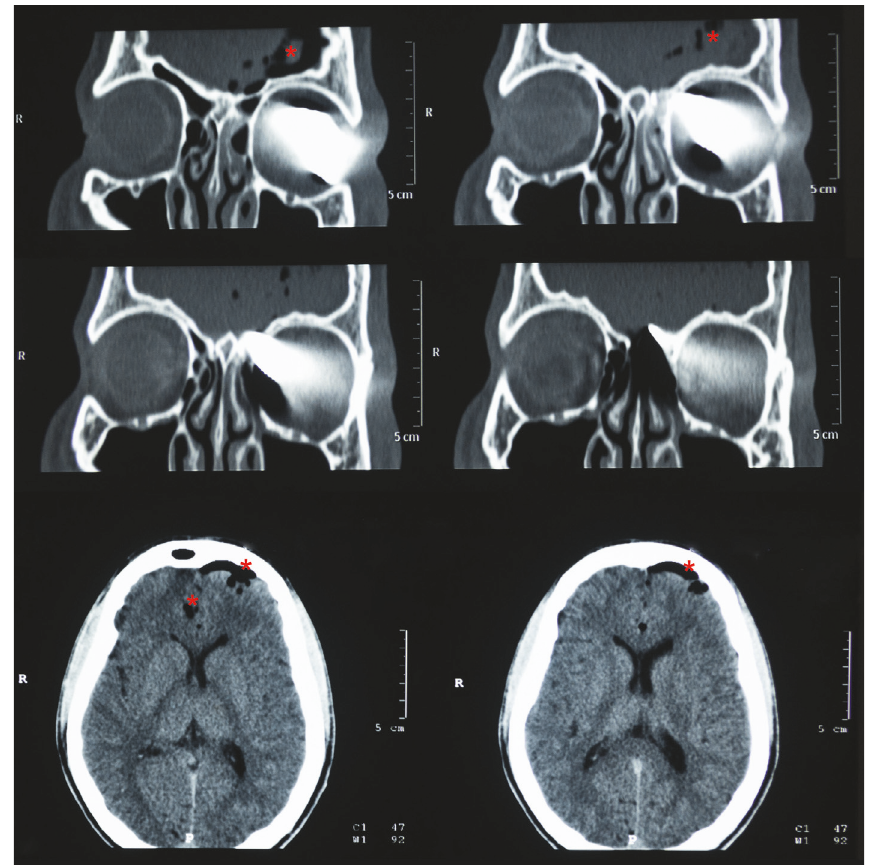
Figure 2: CT scans showing intraorbital foreign body with triangular shape of 4.6 cm x 2 cm in the left orbit, passing through the orbit and the ocular globe, fracturing the superomedial wall of the orbit, with a probable associated fracture of the ethmoidal cells, and reaching the anterior cranial fossa, causing pneumocephalus (marked by